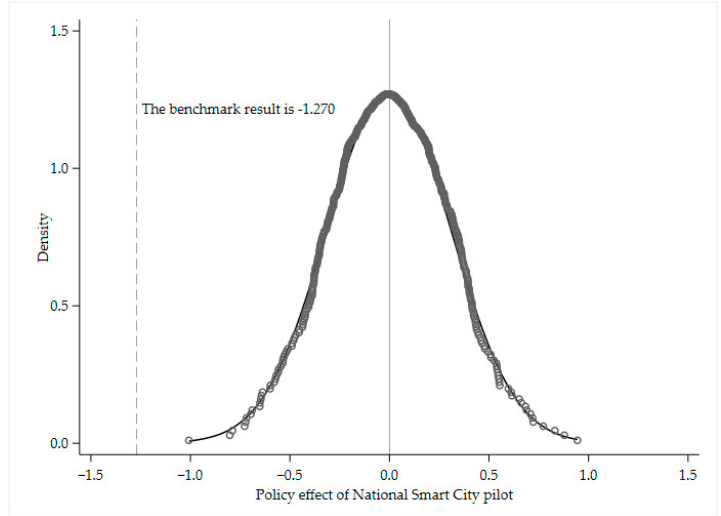
Figure 2. Placebo test results.